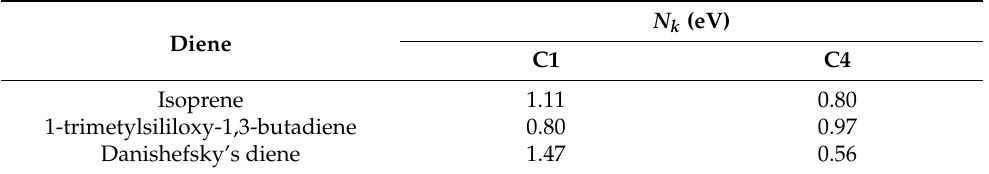
Table 5. Local nucleophilicity indices for